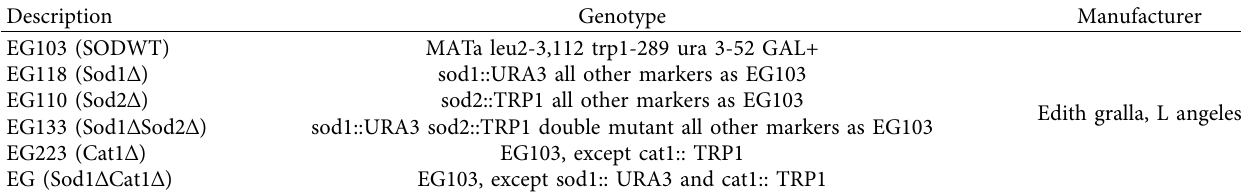
Table 1: S. cerevisiae strains used in this study.